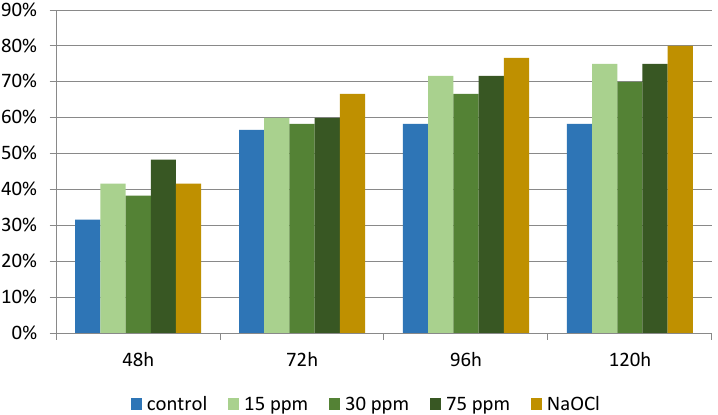
Figure 7. Germination of tomato seeds after immersion in solutions of different concentrations of silver nanoparticles (75 ppm, 30 ppm and 15 ppm) or sodium hypochlorite (NaOCl). The control sample was treated with sterile water. Treatments were compared using analysis of variance and Fisher’s LSD test for each term separately. The letters represent homogeneous groups determined with the assumed significance level of 0.05. Lack of letters means no statistically significant differences.